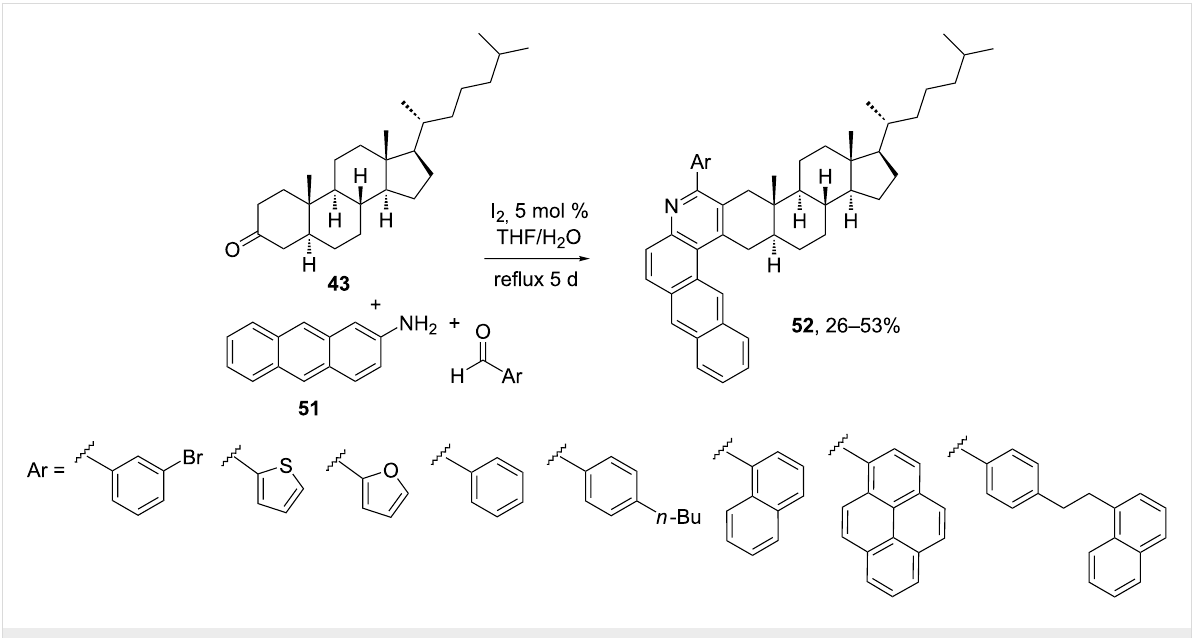
Scheme 16: Synthesis of steroid-fused naphthoquinolines by the Kozlov–Wang MCR using ketosteroids